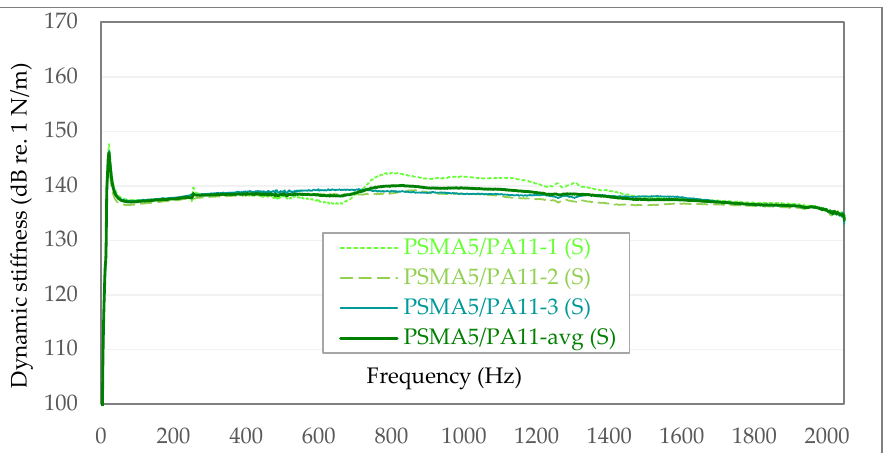
Figure 9. Dynamic stiffness in the case of the PSMA5 poroelastic pavement with PA11 as binder course — in situ measurements (S).